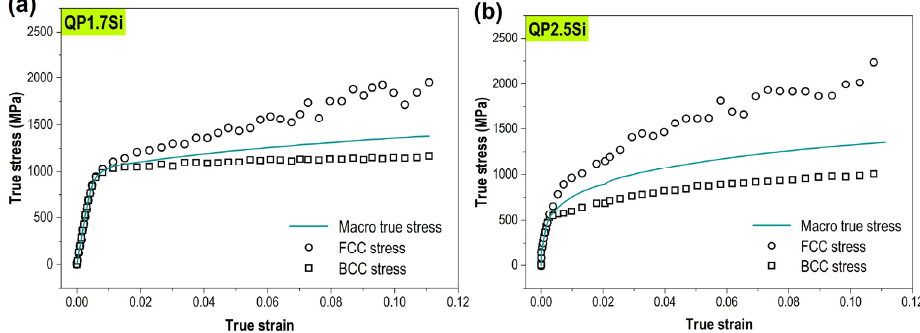
Figure 6. Phase-specific stress–strain behaviors obtained using in situ neutron diffraction. ( a ) QP1.7Si; ( b ) QP2.5Si.